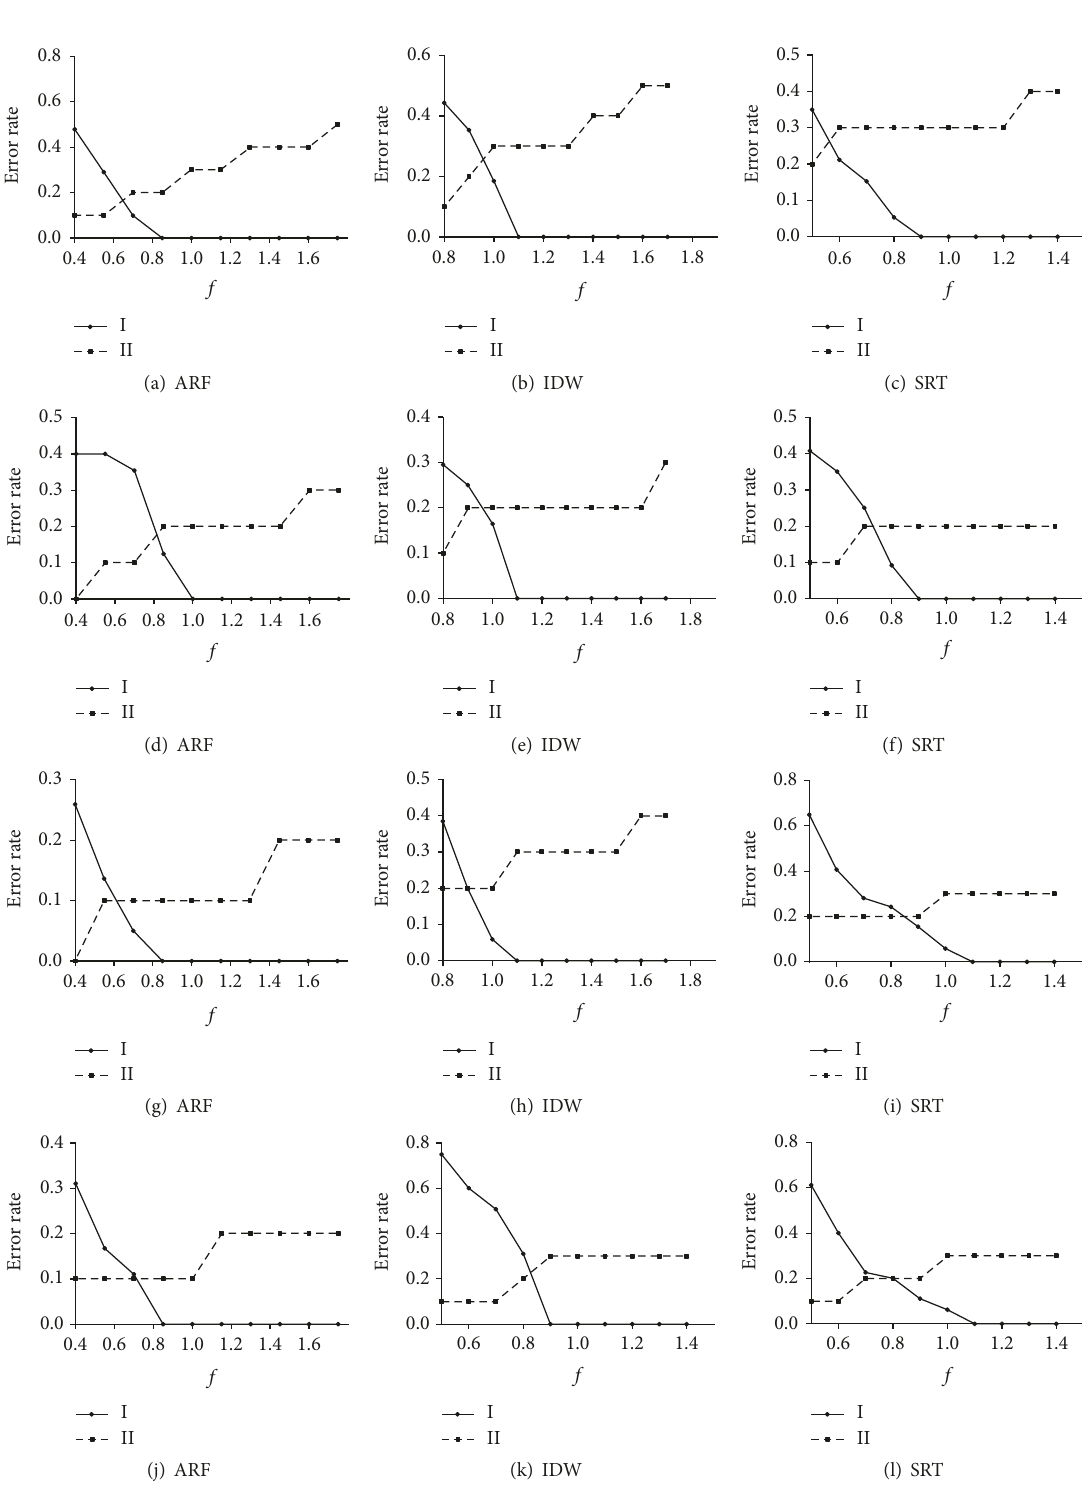
According to formula (7), to evaluate the random inser- tion of an error value in the data, the detection rate is considered as equal to the magnitude of the number of detected errors divided by the total amount of error